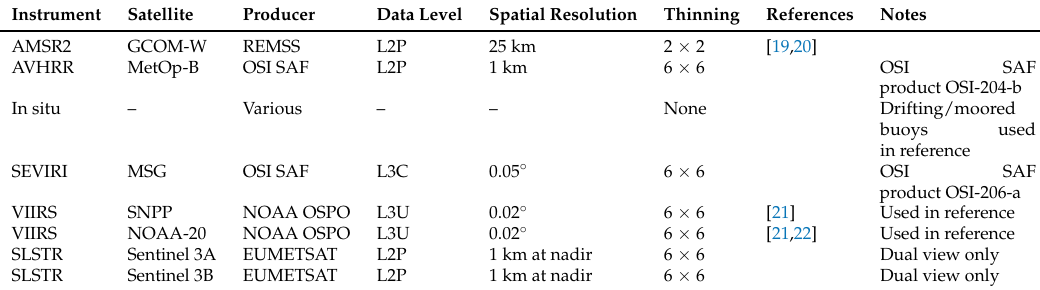
Table 1. List of input sea surface temperature (SST) data used in OSTIA, including the instrument and the satellite on which it is situated, the data producer, the data level (defined in [18]), spatial resolution (as defined in the file metadata), the level of thinning applied (for example 2 × 2 means that 1 in every 2 data values is kept in both dimensions) and citations and notes associated with the data